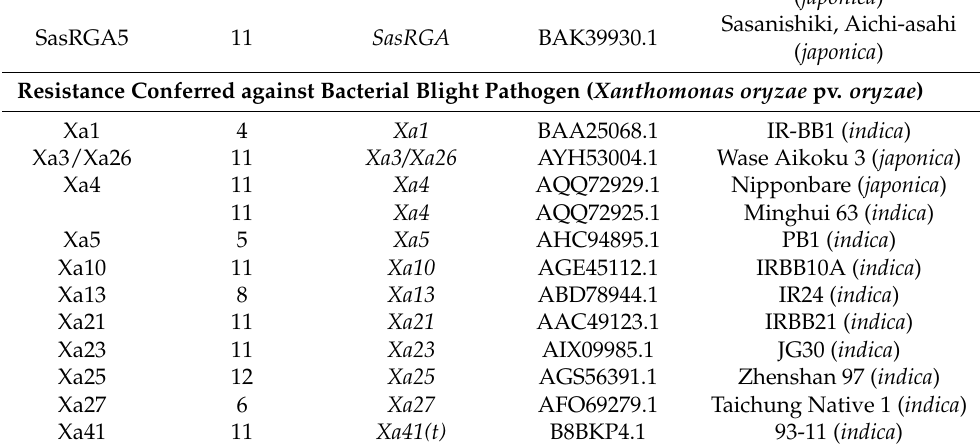
Table 1. Cloned R-gene sequences used in BLASTP searches of the six reference genomes. Details of gene annotations are available via GenBank (www.ncbi.nim.nih.gov (accessed on 10 January 2019)). The allele in the source variety gives resistance to the pathogen indicated.